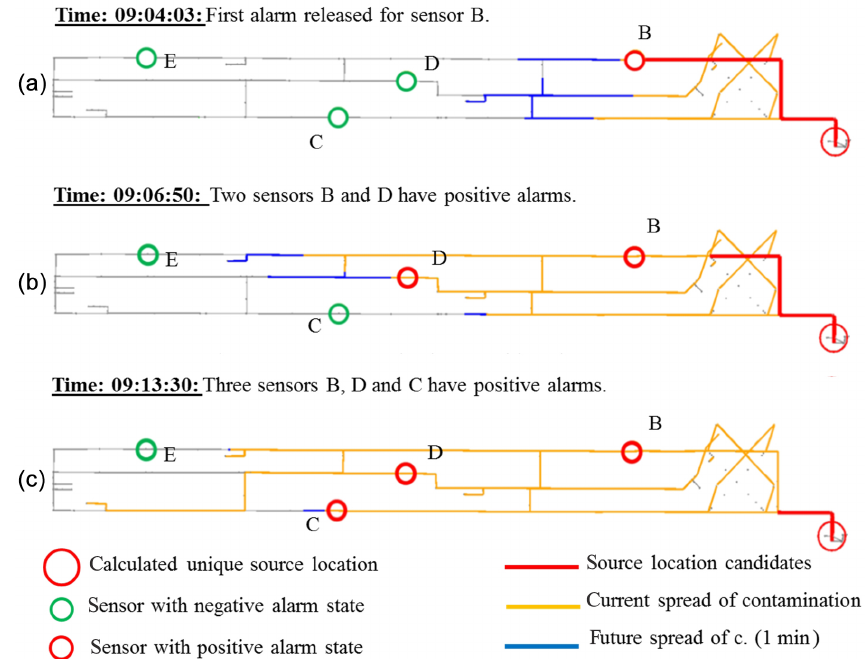
Figure 3. Sequential release of sensor alarms and results of the SI algorithm, current spread of contaminant and